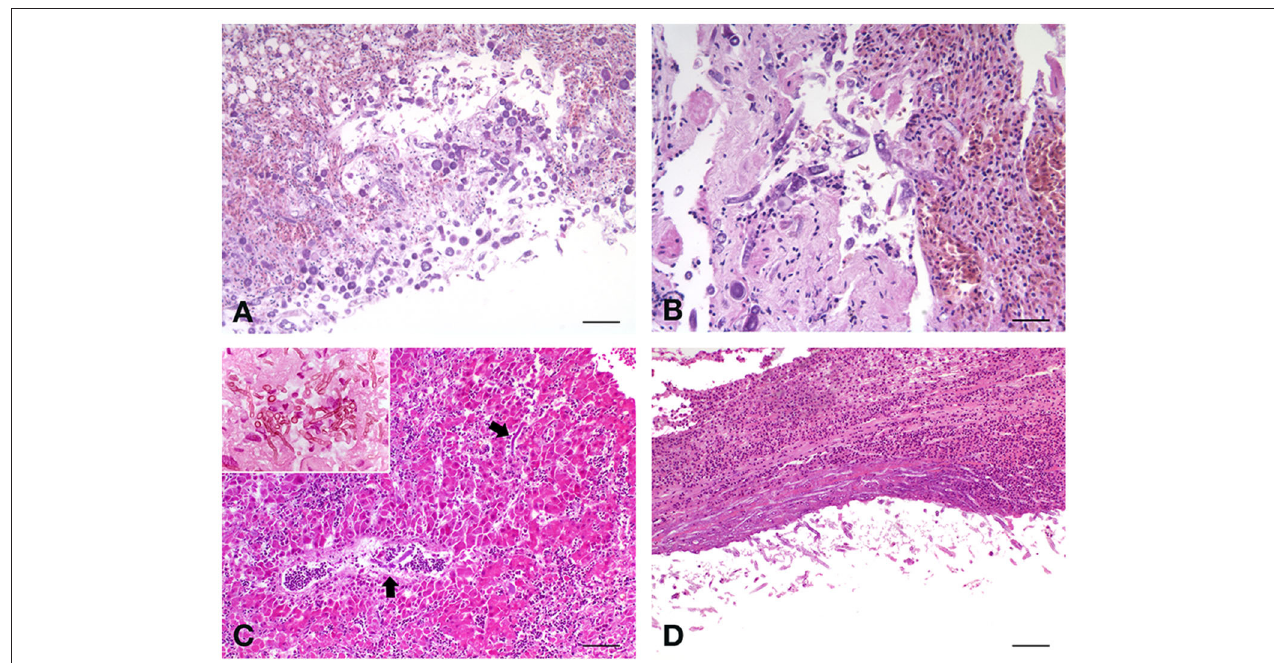
FIGURE 1 | (A) Fischer’s lovebird ( Agapornis fischeri ). Lung parenchyma with the invasive presence of poorly septate large mycotic hyphae, with large sporangiophore, simply spherical and hat-shaped, in the absence of rhizoids relative to the sporangiophores. H&E, scale bar = 250 µ m. (B) Peach-faced lovebird ( Agapornis roseicollis ). Lungs characterized by acute congestion and some areas of parenchyma consolidation, with the presence of mycotic hyphae. H&E, scale bar = 100 µ m. (C) Blue and Gold macaw ( Ara ararauna ), male. Branching septate fungal hyphae were observed in the liver. H&E, scale bar = 250 µ m. Insert, scale bar = 50 µ m. (D) Blue and Gold macaw ( Ara ararauna ), female. Long, septate, branched hyphae were observed also in the kidney, both at the level of the serosa and in the parenchyma. H&E, scale bar = 250 µ